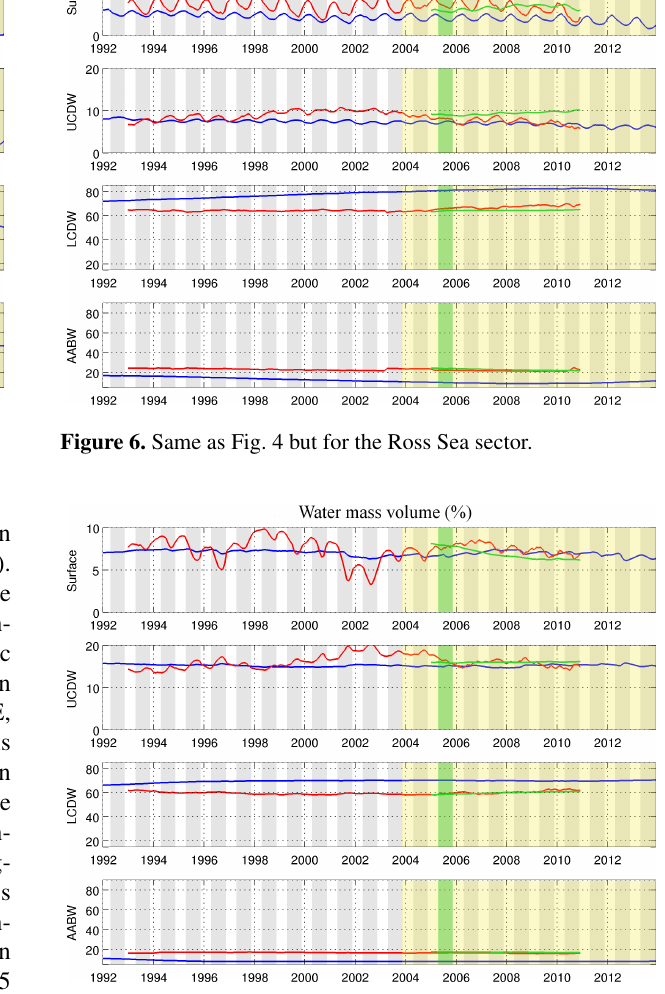
Figure 7. Same as Fig. 4 but for the Bellingshausen and Amundsen